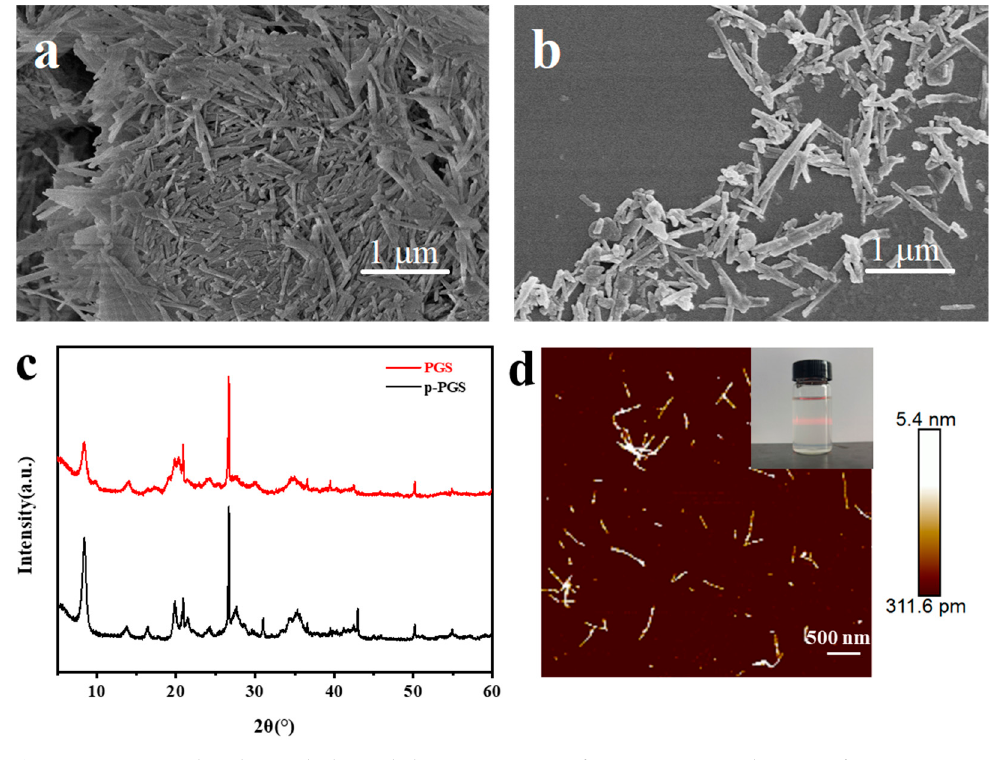
Figure 2. Structural and morphological characterization of p-PGS, PGS, and SNF: ( a , b ) SEM images of p-PGS and PGS; ( c ) XRD patterns of p-PGS and PGS; ( d ) AFM image of SNF. The inset is the SNF solution with an obvious Tyndall